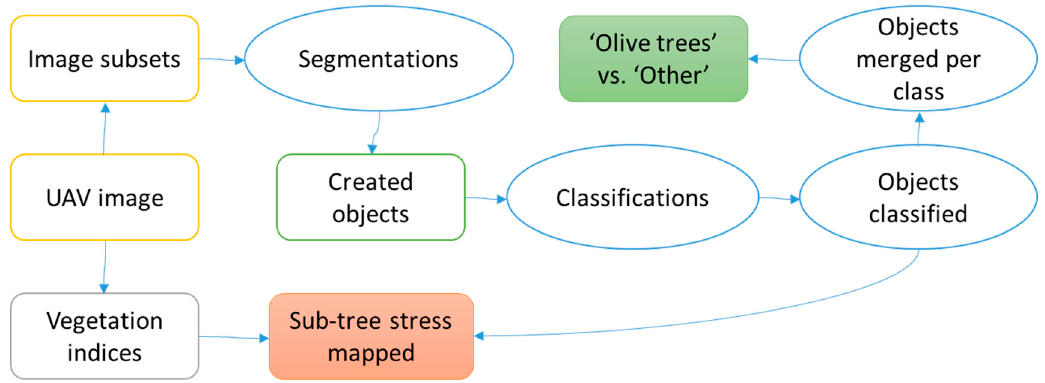
Figure 2. An overview of the classification methodology and the potential of stress assessment on a sub-tree scale.